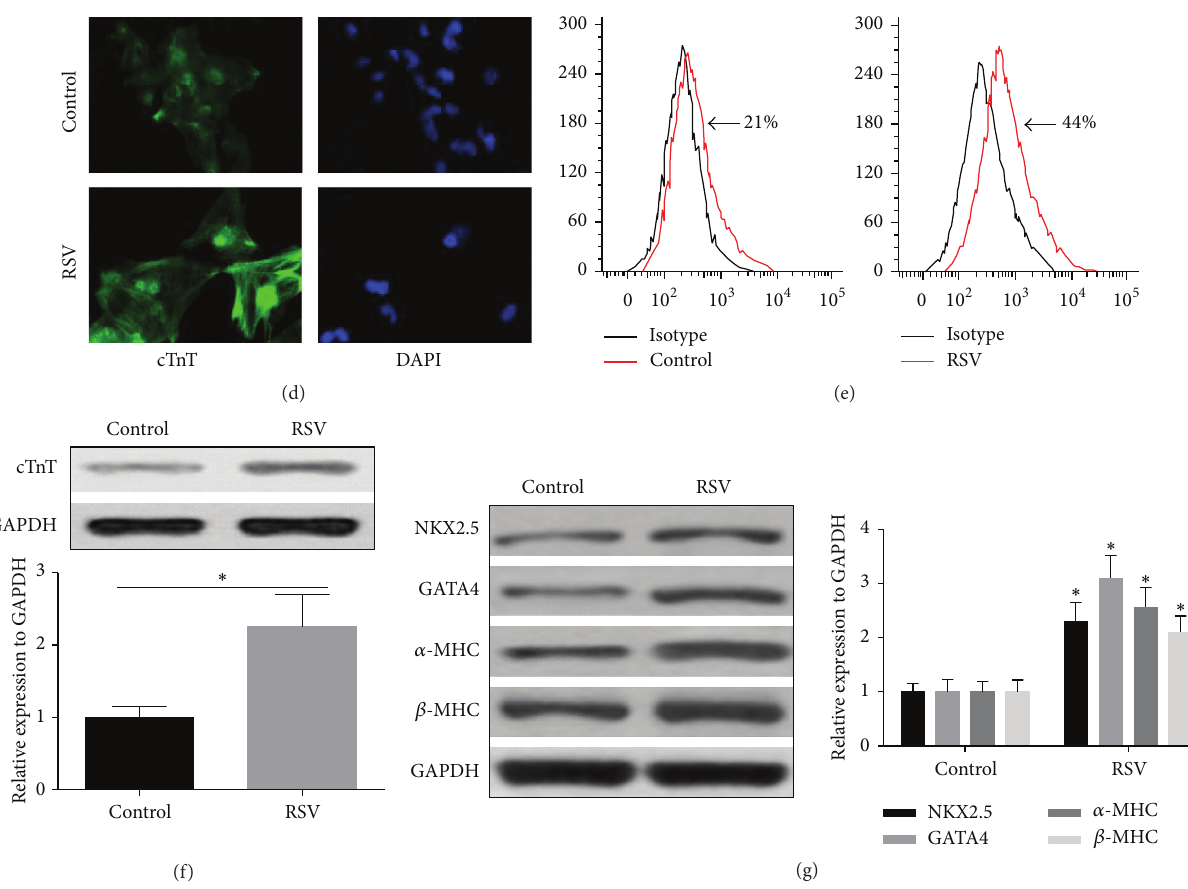
Figure2:RSVenhancesCMdifferentiationofhumaniPSCs.(a)Aprotocoloutlineddescribingthecardiovasculardifferentiationstrategy.(b) Ratios of beating EBs in control and RSV group from day 8 to day 24 of differentiation, respectively ( 𝑛 = 100 ). (c) Gene expression profile of pluripotency, cardiomyocyte specific markers during differentiation process by qRT-PCR analysis. (d) A representative immunofluorescent image of comparison of cTnT positive CMs from dissociated day 24 EBs between control and RSV groups (40x). (e) Flow cytometry was performed to compare the percentage of cTnT positive cells between control and RSV group at day 24. (f) cTnT protein level was further compared using Western Blot method at day 24. (g) Western Blot analysis was further performed to confirm the cardiomyocyte specific genes (as shown in (c)) at protein levels. Data represent the mean ± s.d. of three biological replicates. ∗ 𝑃 < 0.05 , ∗∗ 𝑃 < 0.01